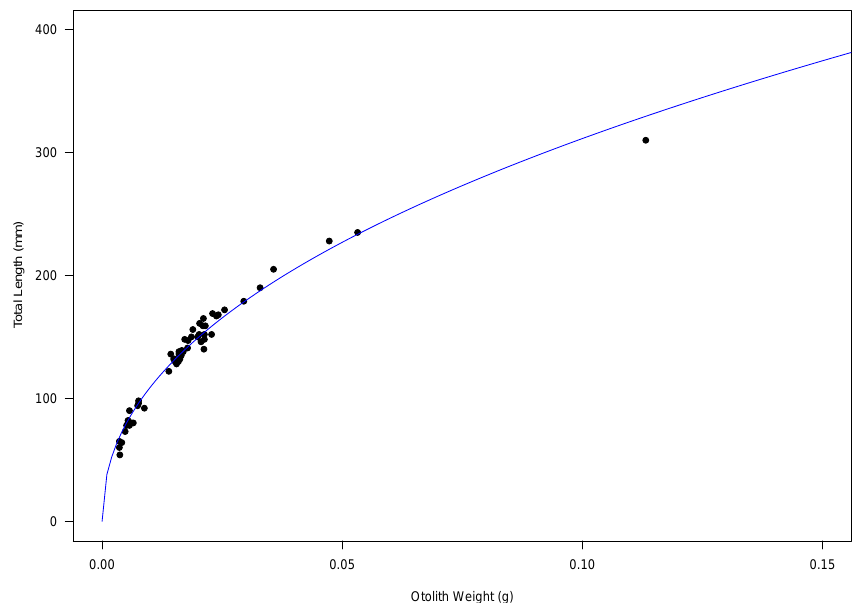
Figure 2. Relationship of L. harak otolith weight (g) to fish total length (mm). Data are represented by the black dots and the line represents the model L = 890.4 O 0.456 , where L and O represent individual length and otolith mass, respectively.